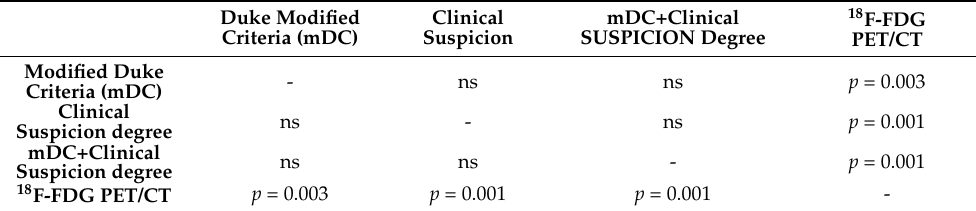
Table 3. Head-to-head comparison (global accuracy for IE diagnosis) between mDC, clinical suspicion degree, the combination of both, and 18 F-FDG